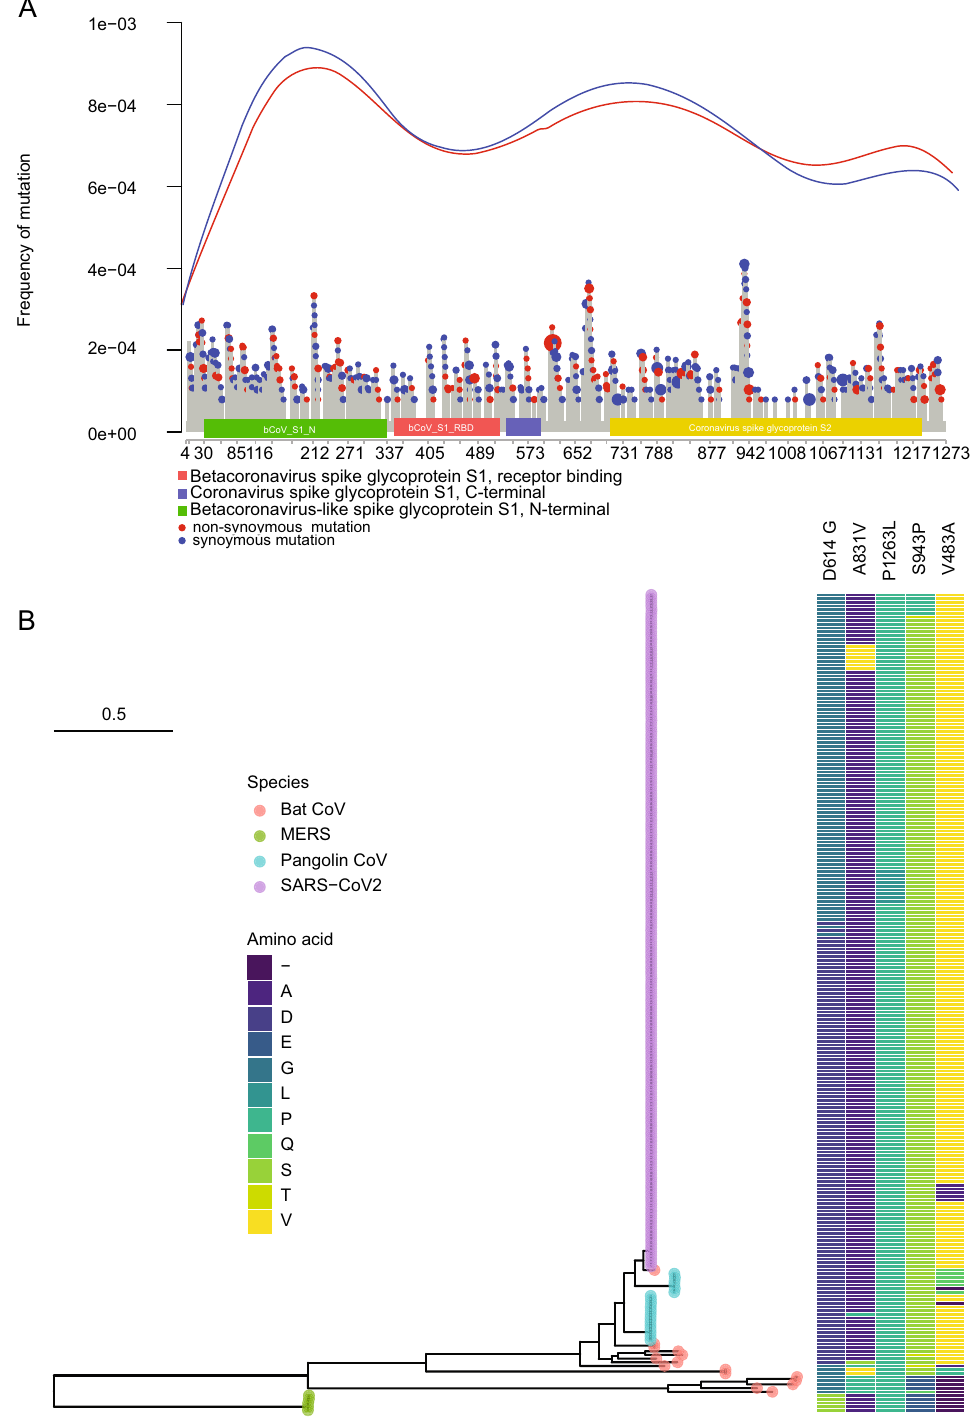
Figure 4. Particular nonsynonymous mutations (identified in 5,248 viral genomes) are enriched in the S protein ( A ) and particular mutations (e.g ., D614G) are frequent (occurring more than 20 times early in the pandemic) and retained in human, bat, and pangolin coronaviruses ( B ). None of the common variants are fixed in human populations. The tree of common variants is a maximum likelihood tree. The mutations are color coded by amino acid for taxa in the tree. Each colored tip in the tree is made up of one or more samples. The human samples are numerous, and the merging of many dots for many samples gives rise to the purple